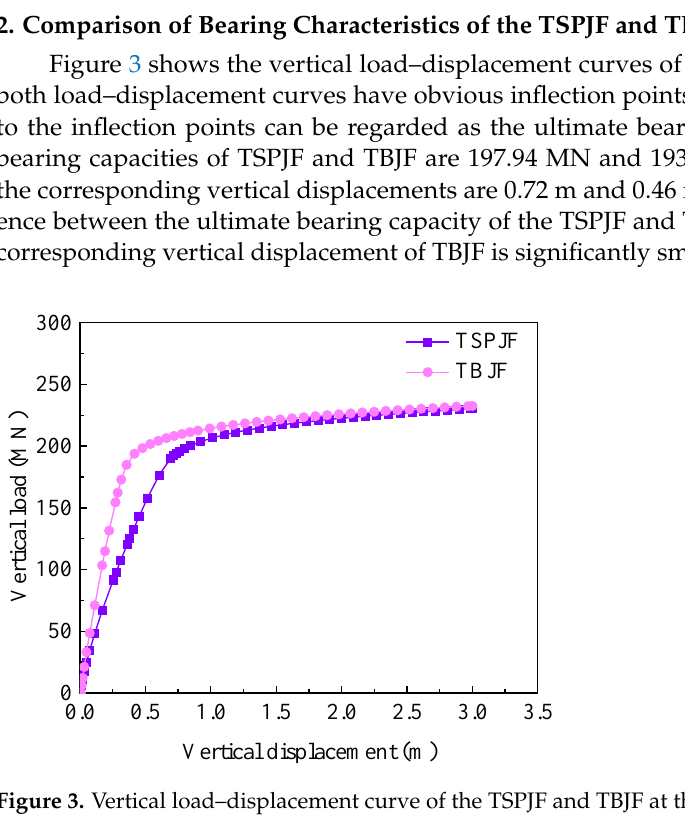
( b ) Figure 4. Soil equivalent plastic strain contours at the 2# and 3# bucket central section for the TSPJF and TBJF under the ultimate vertical load. ( a ) TSPJF, ( b ) TBJF. Figure 5 shows the distribution of the earth pressure inside and outside skirt wall at the positions of P1 and P2 of 1# bucket ( see Figure 1c) along the skirt height. The compar- ison of inside and outside earth pressure at positions P1 and P2 of 1# bucket of the TSPJF and TBJF along the bucket height is displayed in Figure 6. In general, the earth pressure of the two foundations has similar variation trends. The earth pressure inside the bucket is generally higher than the earth pressure outside the bucket, which is mainly because the soil inside the bucket is constrained by the bucket skirt. For the two foundations, the earth pressure inside the bucket generally increases with the increase in depth, and the increase in TSPJF is more significant. The outside earth pressure of 1# bucket of the TSPJF at P1 and P2 first increases and then decreases with the increase of depth, and the change of outside earth pressure at P1 is relatively small. Different from the TSPJF, the outside earth pressure of 1# bucket of TBJF does not decline at P1, but increases with the increase of depth. The reason may be that the plastic failure zone of the soil at the end of the bucket is different in the ultimate bearing state (see Figure 4), and the plastic failure of the soil outside the bucket around the end of the bucket of the TSPJF is more serious in the ulti- mate state.